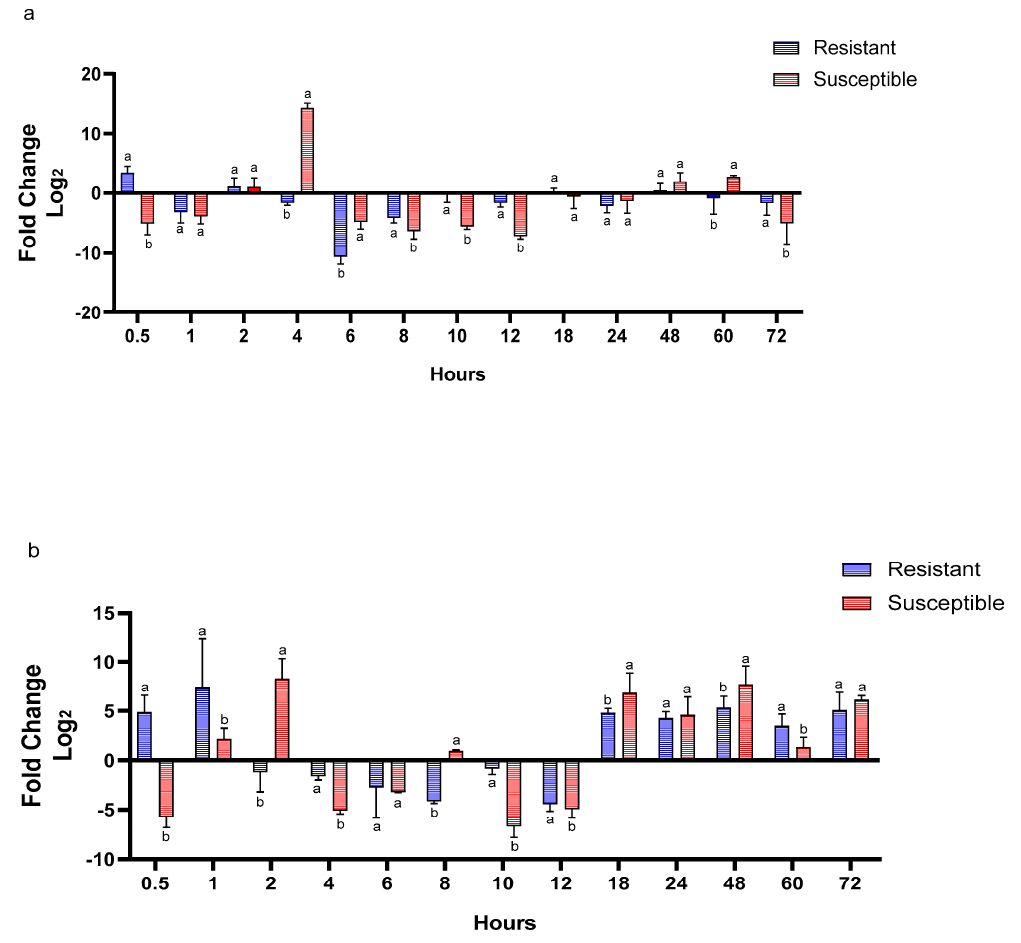
Figure 5. Real-time quantitative Fold change results comparing TPS-3 and TPP-1 genes in resistant and susceptible maize (Zea mays ) seedlings under drought stress. Expression data were reported as Log 2 2 ( − ∆∆ Ct) , upregulated detectors take a positive value while repressed detectors are negative this relatively with the well-watered conditions. The values are means ± SD. Different letters show significant differences between lines at the same period of time ( p < 0.05) according to Tukey’s test: ( a ) Relative expression of TPS-3 gene in leaves from resistant and susceptible maize seedlings; ( b ) Relative expression of TPP-1 gene in leaves from resistant and susceptible maize seedlings.